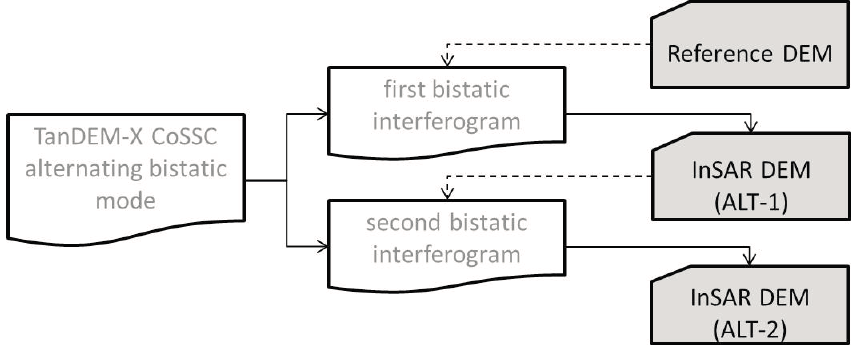
Figure 2. Graph of the interferometric workflow for the TanDEM-X DEM